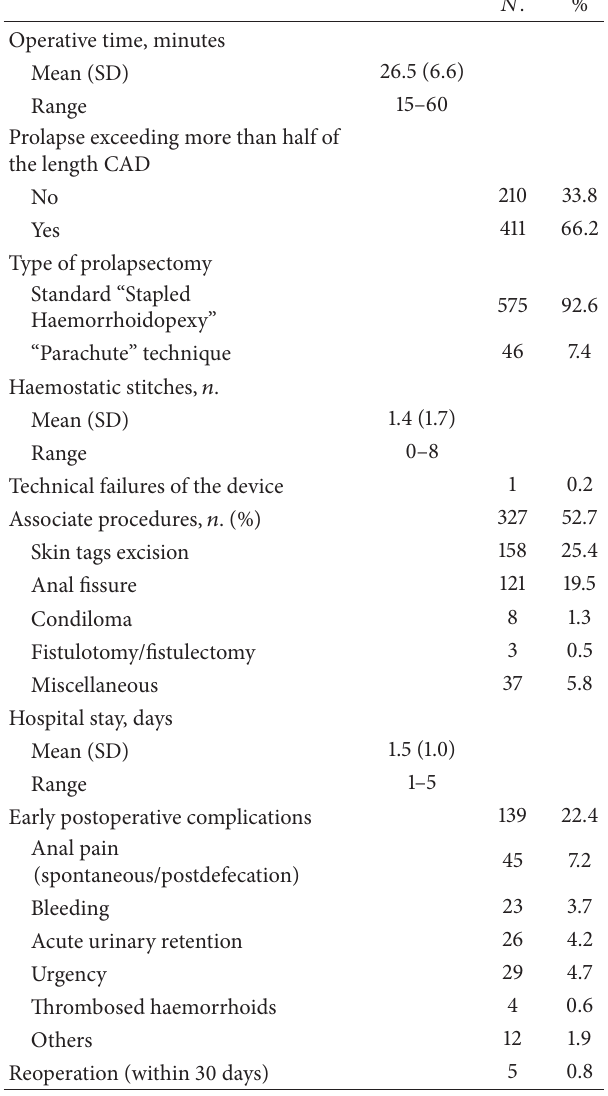
Table 2: Intra- and early postoperative findings ( 𝑁 = 621 patients). 𝑁 .